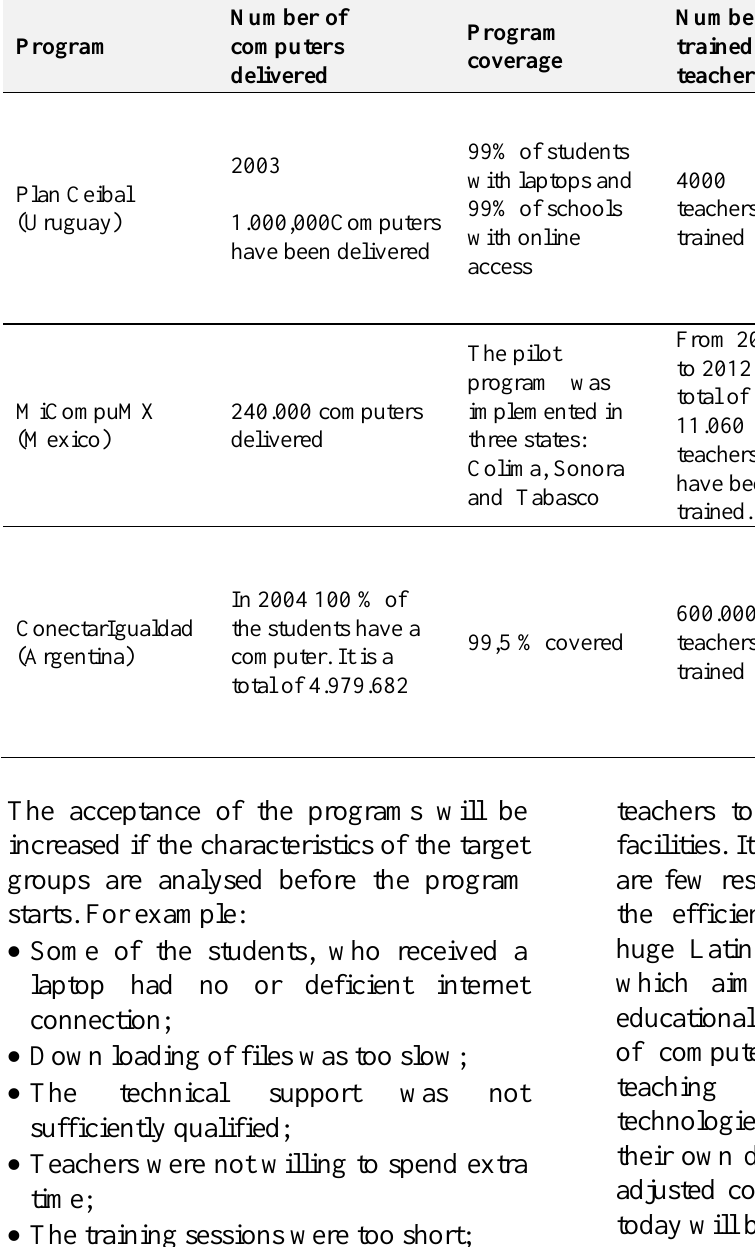
Table 1. Comparison of national